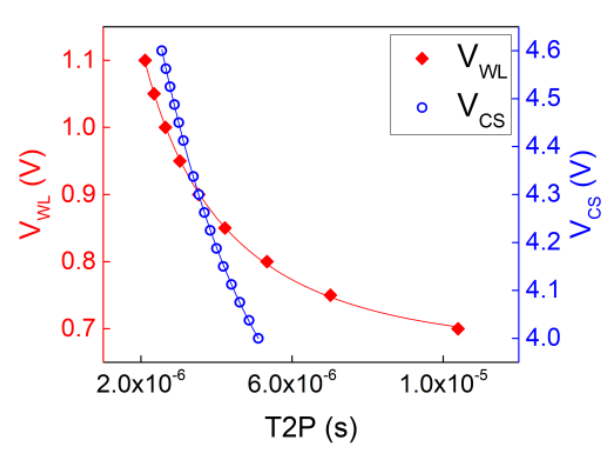
Figure 11. TCAD simulations of time-to-program drawn as function of V WL (solid symbols) and V CS (open symbols), in their respective operating ranges. The two solid lines are exponential interpola- tions.